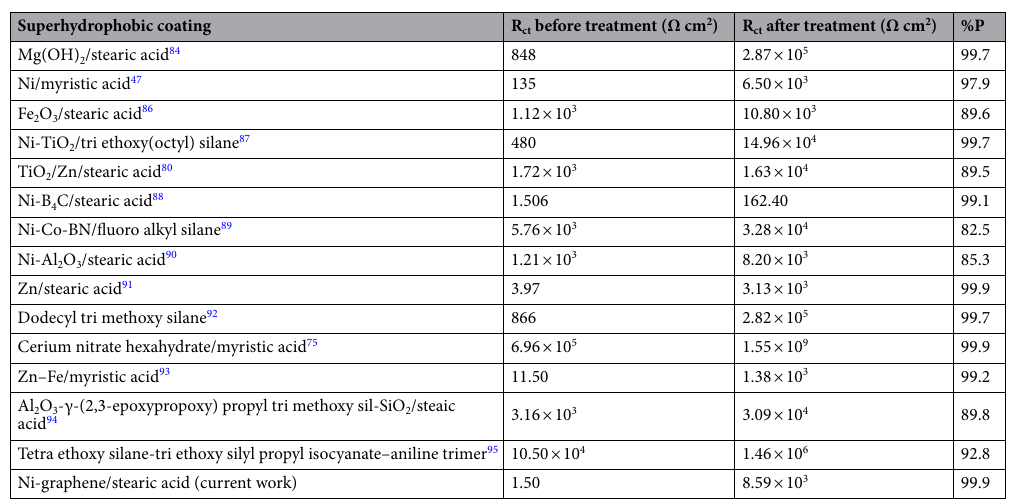
Table 6. Comparison of the of the recently published investigations on the corrosion resistance of the superhydrophobic surfaces on the steel substrate with the prepared superhydrophobic surface.